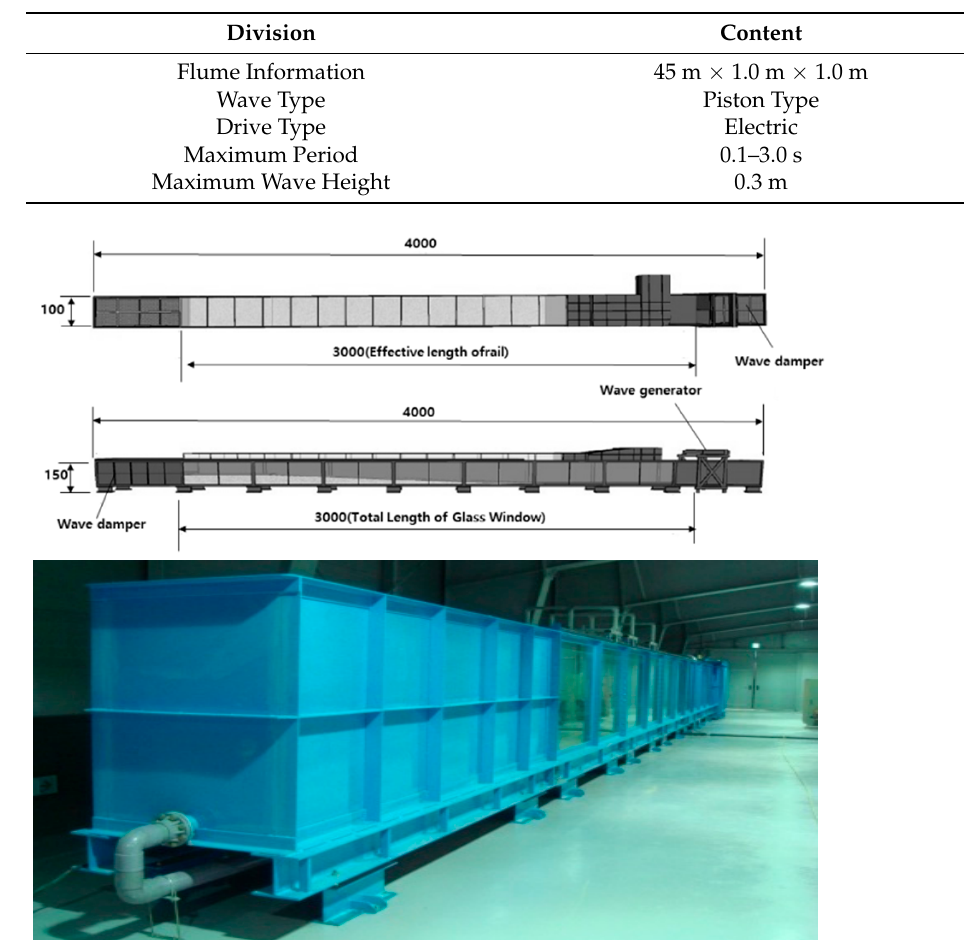
Figure 4. Sunken vessel model produced by 3D printer. Table 4. The specification of the 2D cross-sectional wave flume.